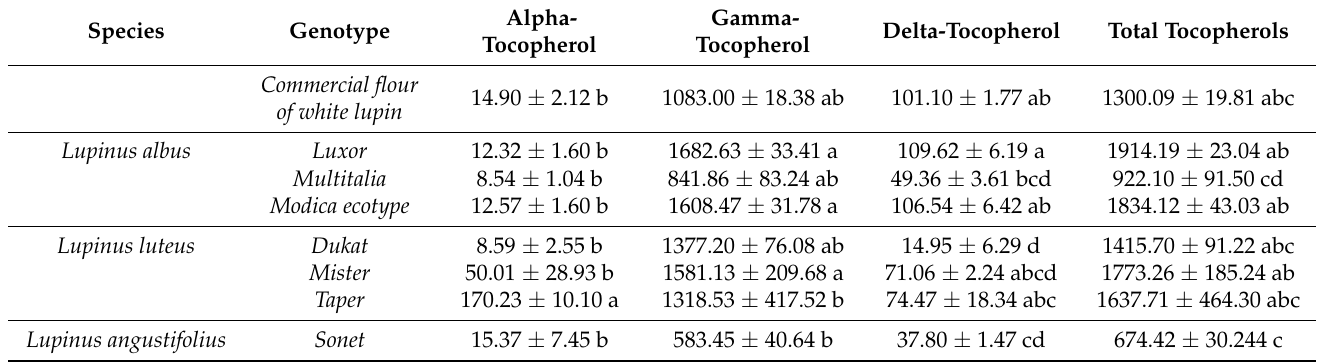
Table 7. Proximate tocopherol compositions of seed oil extracted from different Lupinus spp.